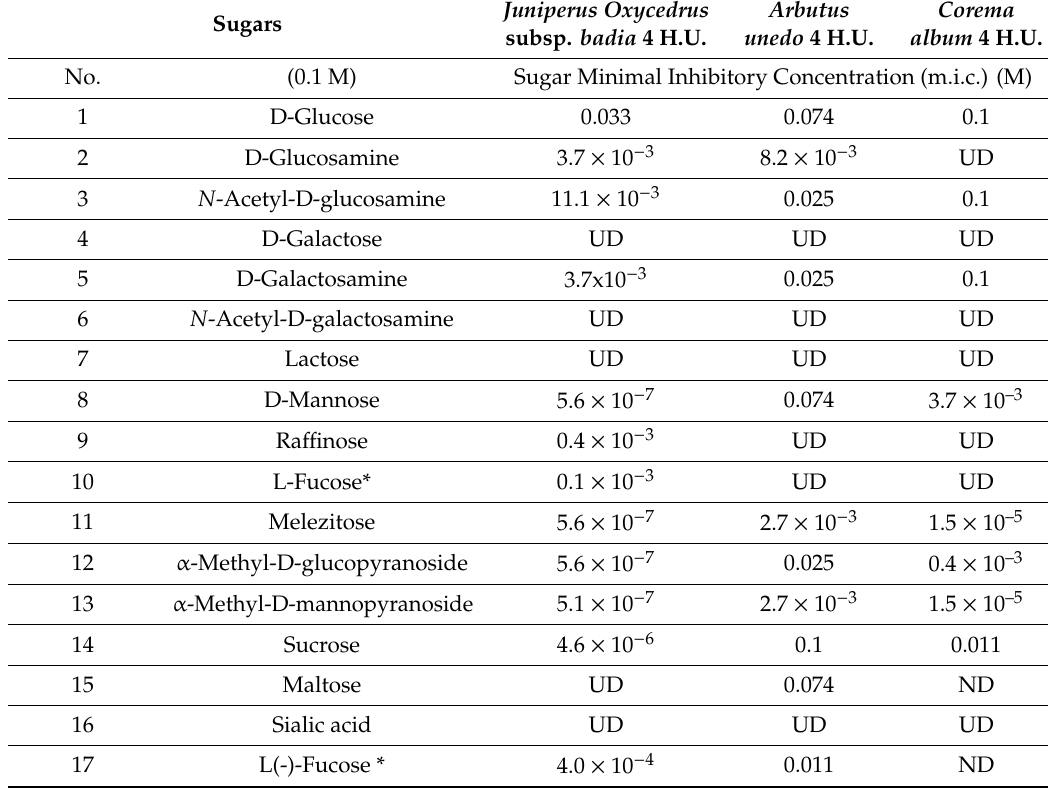
Table 2. Haemagglutination activity inhibition by